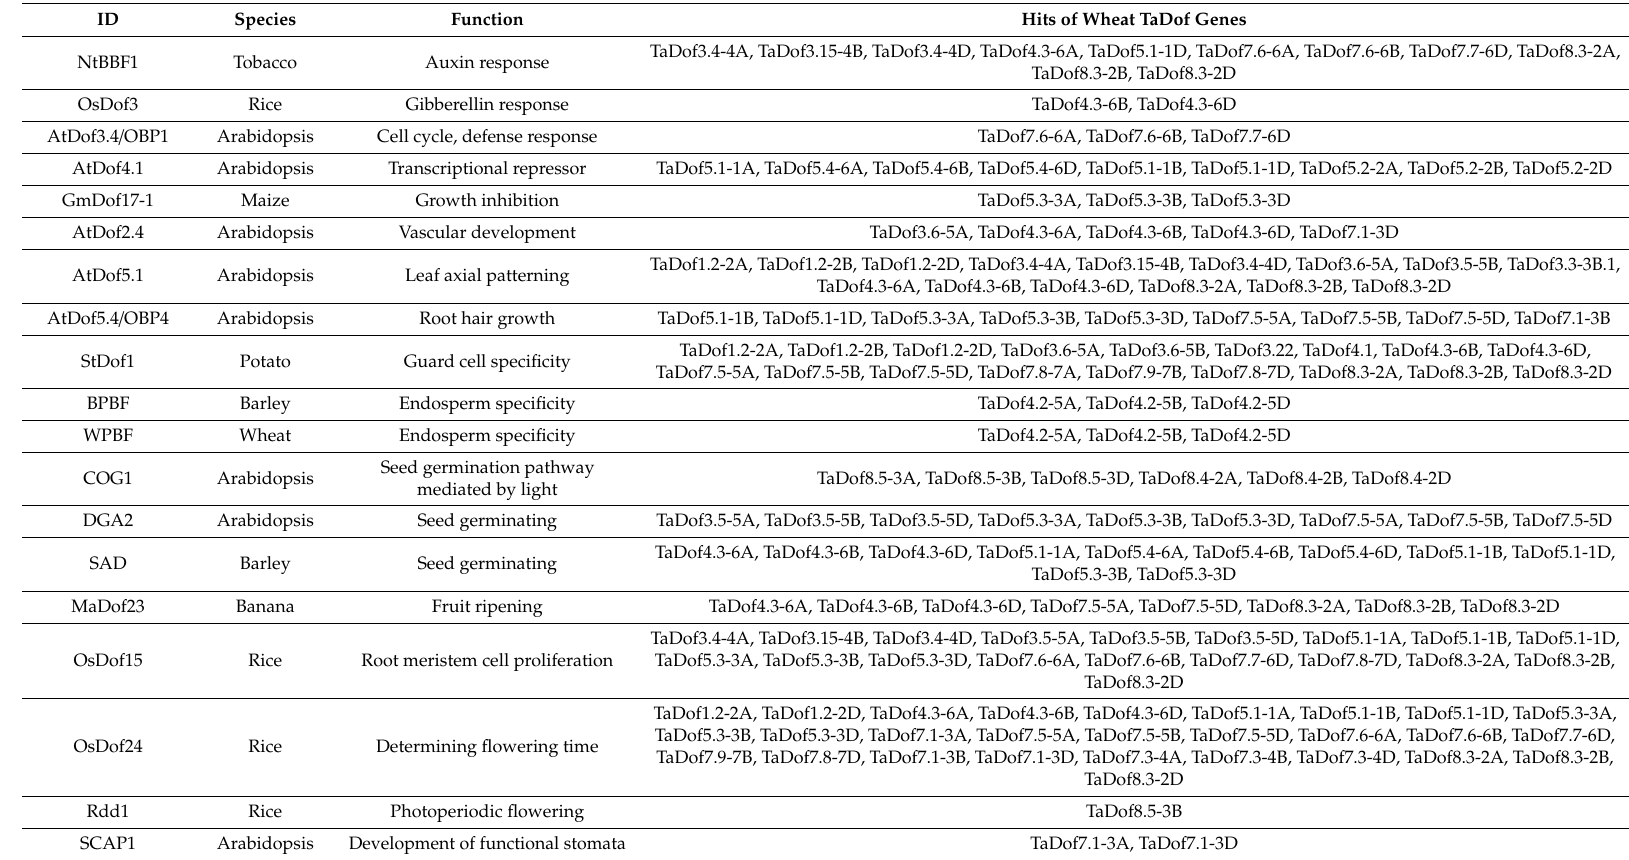
Table 2. Customized functional annotations of